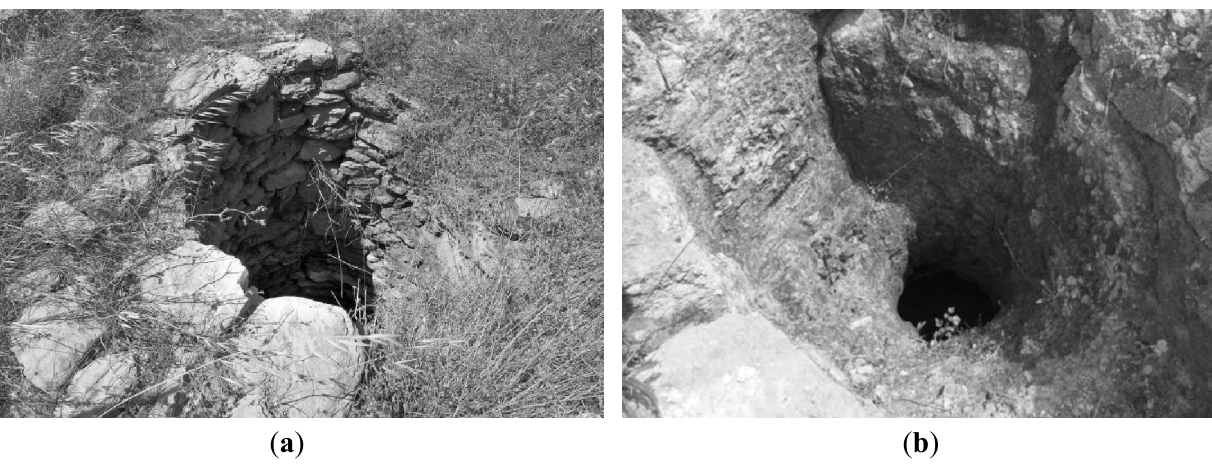
Figure 5. Minoan well used for water supply at Palaikastro city, eastern Crete ( a ) and Well at the location Campetti , Etruscan City of Veio north of Rome ( b